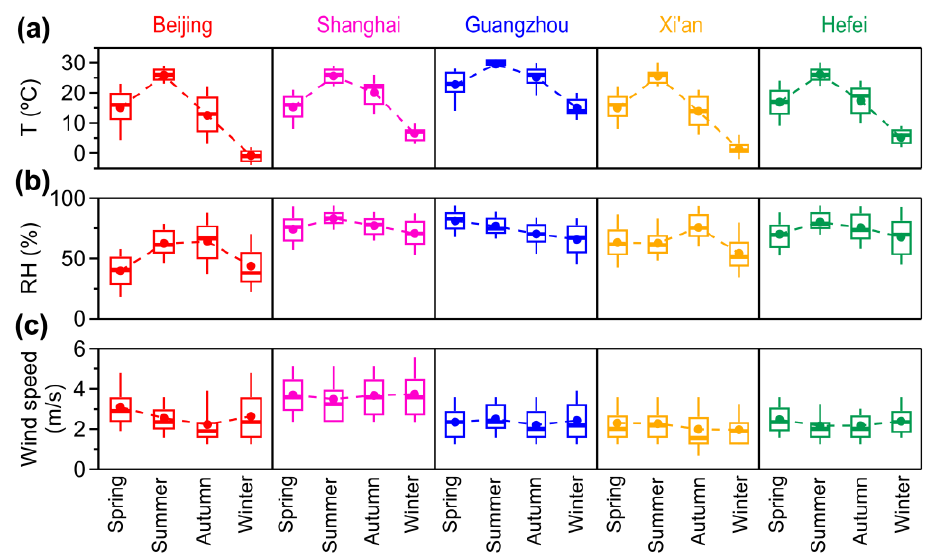
Figure 6. Seasonal variations of temperature ( a ), relative humidity ( b ) and wind speed ( c ) in the five cities. The boxes represent the 25th percentile (lower edge), median (solid line), mean (dot with das line), and 75th percentile (upper edge). The whiskers above and below the box indicate the 90th percentile and 10th percentile.